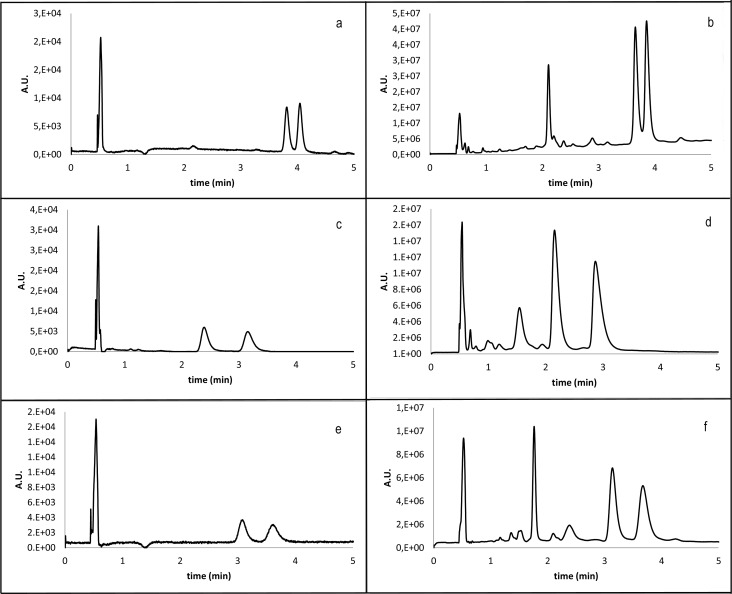
Example of SFC chromatograms of pure and crude mixtures of oxazines 11(R1,X,R2) and 12(R1,X,R2).a) 12(1,1,3) pure compound; b) 12(1,1,3) crude mixture; c) 12(4,1,1) pure compound; d) 12(4,1,1) crude mixture; e) 11(1,1,3) pure compound; f) 11(1,1,3) crude mixture.